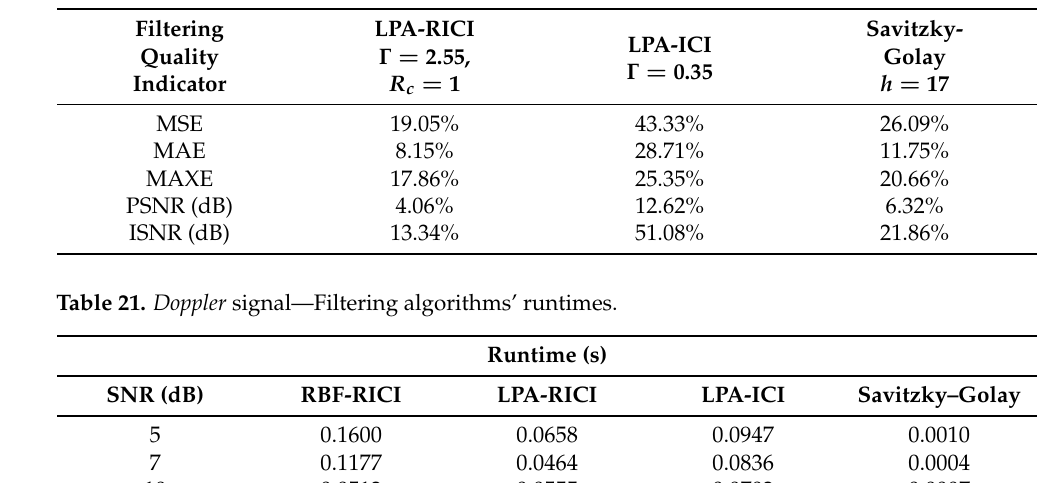
Table 20. Doppler signal (SNR = 10 dB)—Filtering quality improvement of the RBF-RICI-based filtering over other tested algorithms.